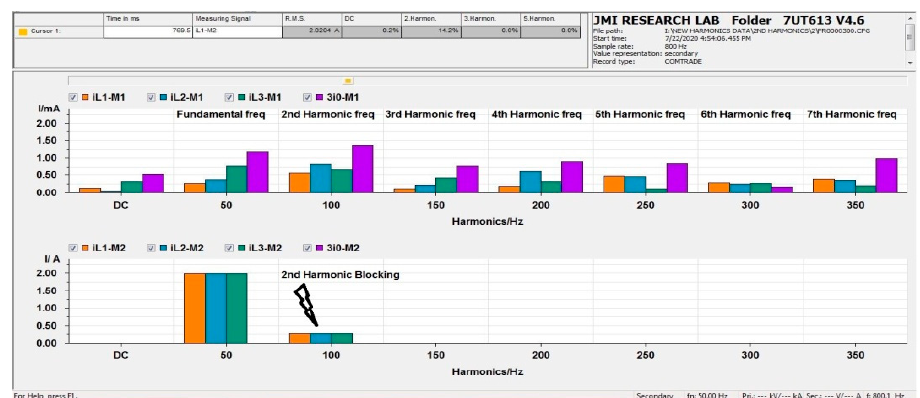
Figure 10. 2nd HB at 1000 mA Rated current & 20% of Inrush current condition.